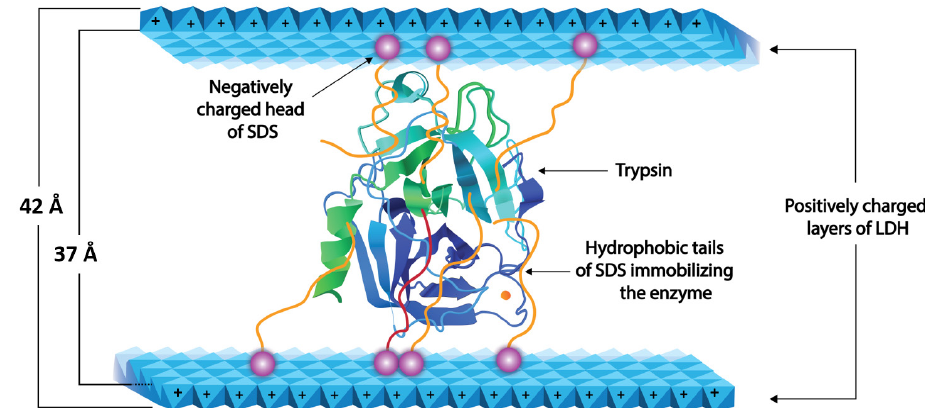
Figure 7: Schematic diagram illustrating immobilization of enzyme via entrapment of SDS